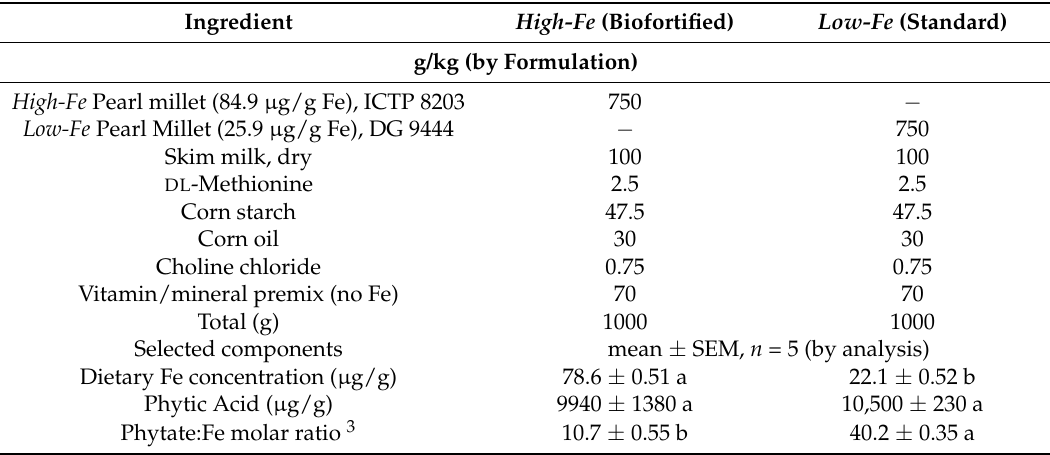
Table 3. Composition of the experimental diets 1–3